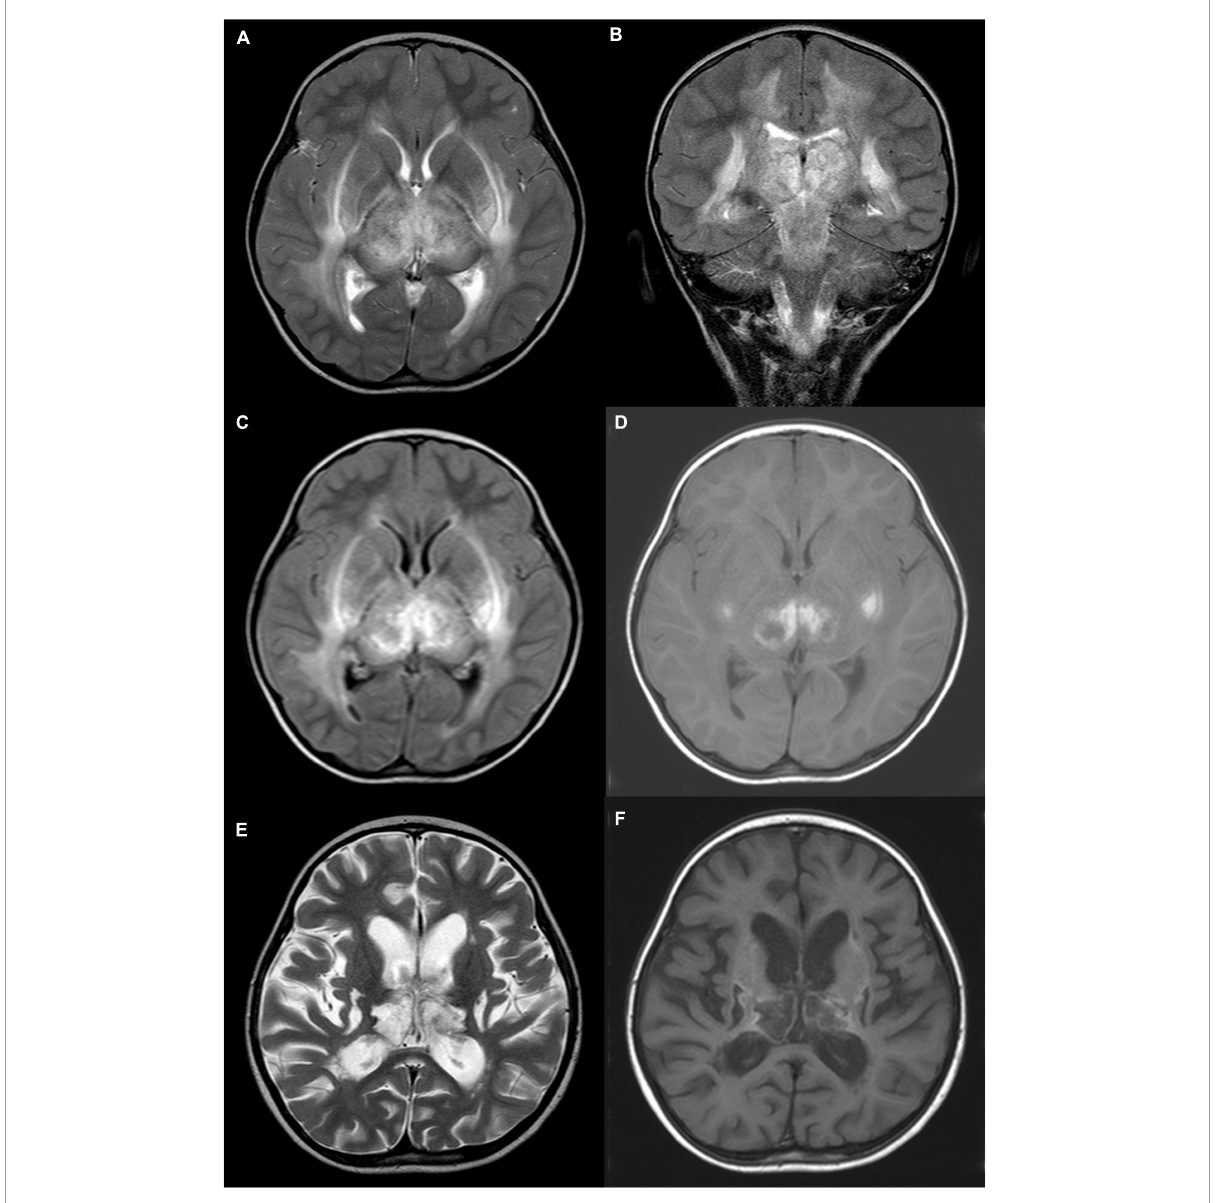
FIGURE1 A 4-year-old girl with acute necrotizing encephalopathy, with fever for 1 day and coma. (A) T2WI cross-section shows slightly high signal intensity in bilateral thalamus, putamen, posterior limb of the internal capsule, external capsule, outermost capsule, and peripheral matter of posterior horn of lateral ventricle. (B) On T2WI coronal view, uneven, slightly high signal intensity is seen in the cerebral peduncle, midbrain, and dorsal pons. (C) T2WI water suppression cross-section shows slightly high signal intensity in bilateral thalamus, putamen, posterior limb of the internal capsule, external capsule, outermost capsule, and peripheral matter of posterior horn of the lateral ventricle. (D) T1WI plain cross-sectional shows patch-like hyperintensity in the bilateral thalamus and putamen. (E) Eight months later, T2WI cross-section shows irregular cystic hyperintensity in bilateral thalamus and putamen. (F) Eight months later, T1WI plain cross-sectional shows irregular cystic hypo-signal in bilateral thalamus and